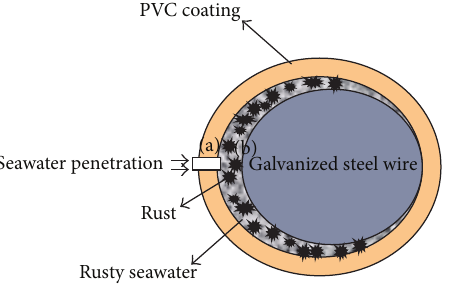
Figure 1: Schematic diagram of galvanized steels coated by PVC: (a) the failure zone of the PVC coating, (b) the corroded surface of the galvanized steel.